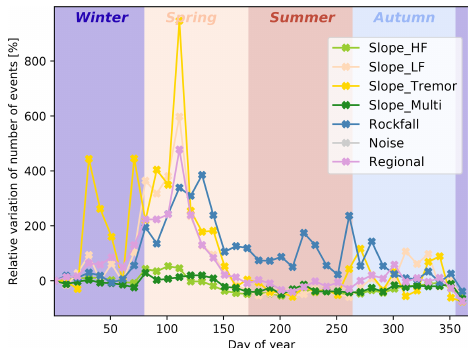
Figure B13. Relative variations R of the number of events N per class over chunks of 10d. The reference value is taken from the first chunk; i.e. we compute R = ( N − N (1)) /N (1). Note that noise events are so rare that they are not visible in the plot.